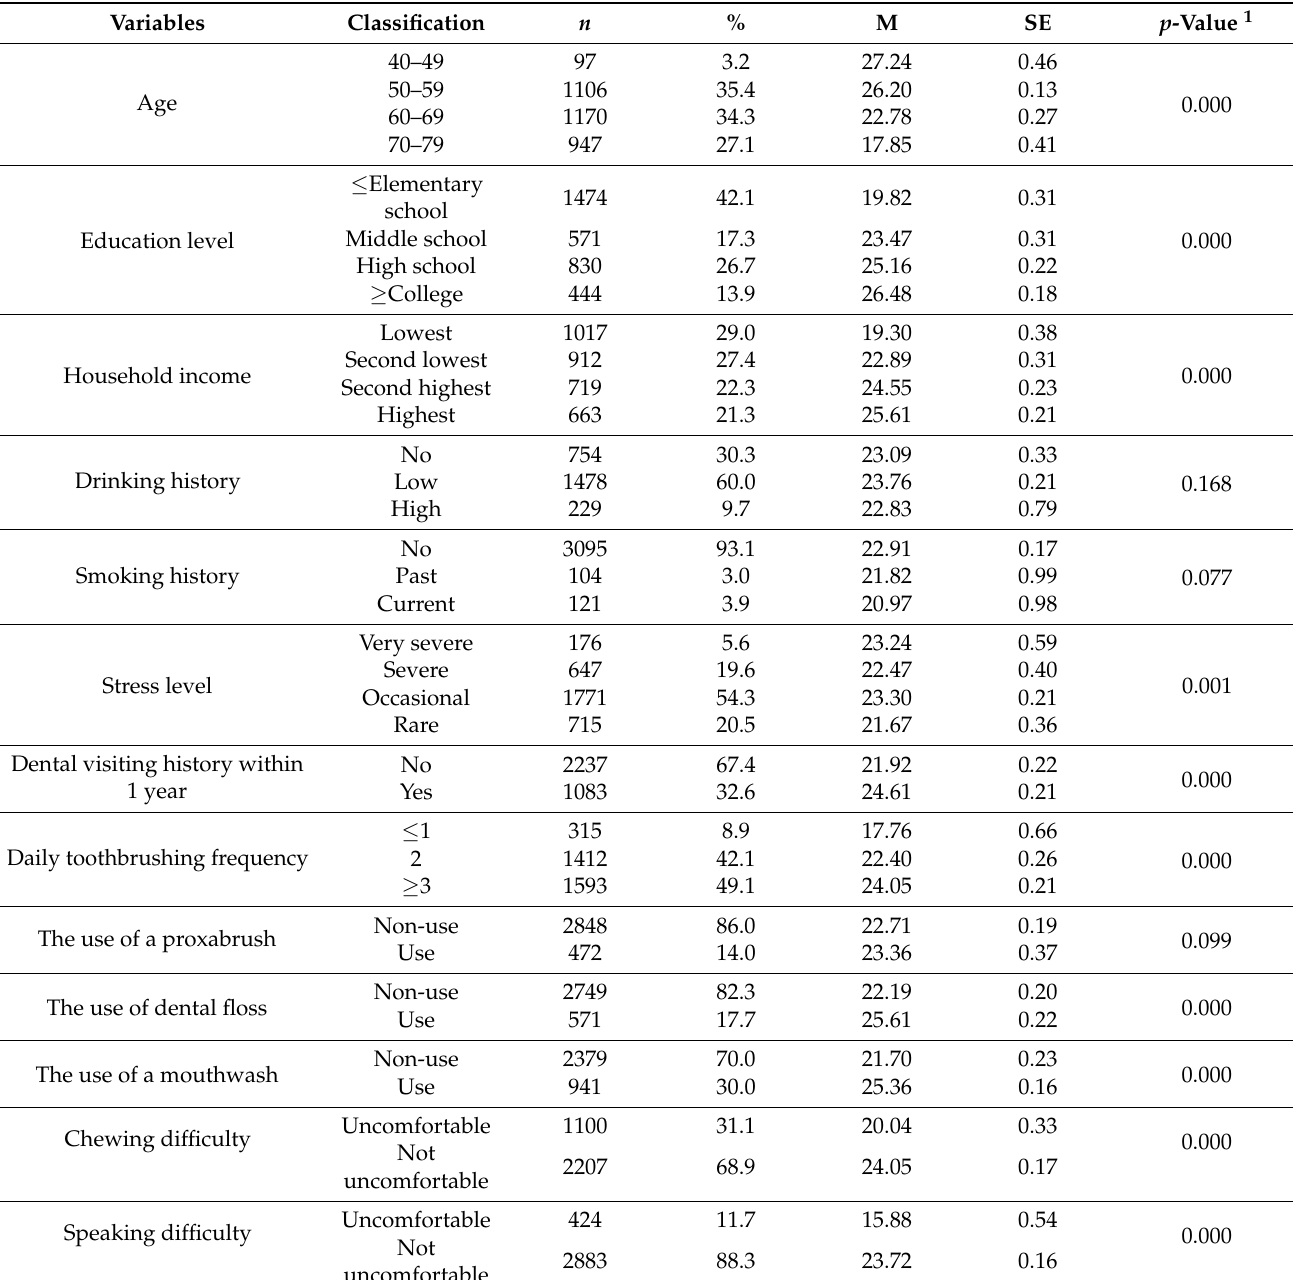
Table 1. Number of remaining teeth according to sociodemographic characteristics and health status and